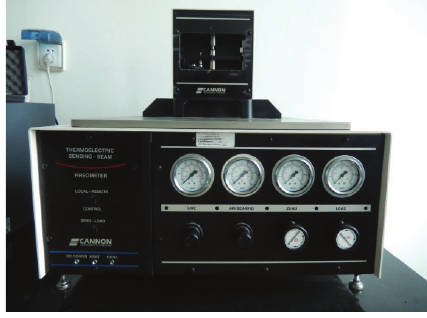
Figure 4: Bending beam rheometer